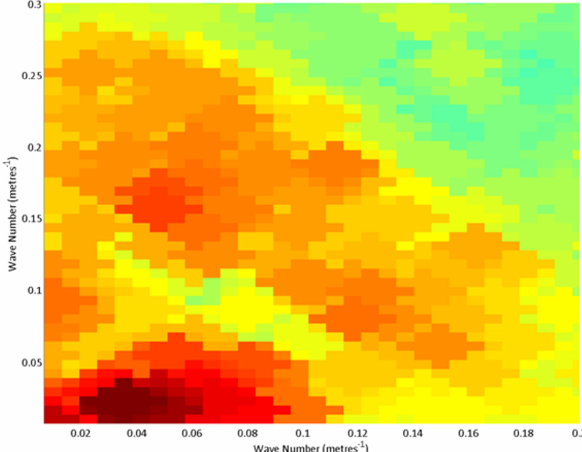
Fig. 6. Post filtered two-dimensional FFT of wave